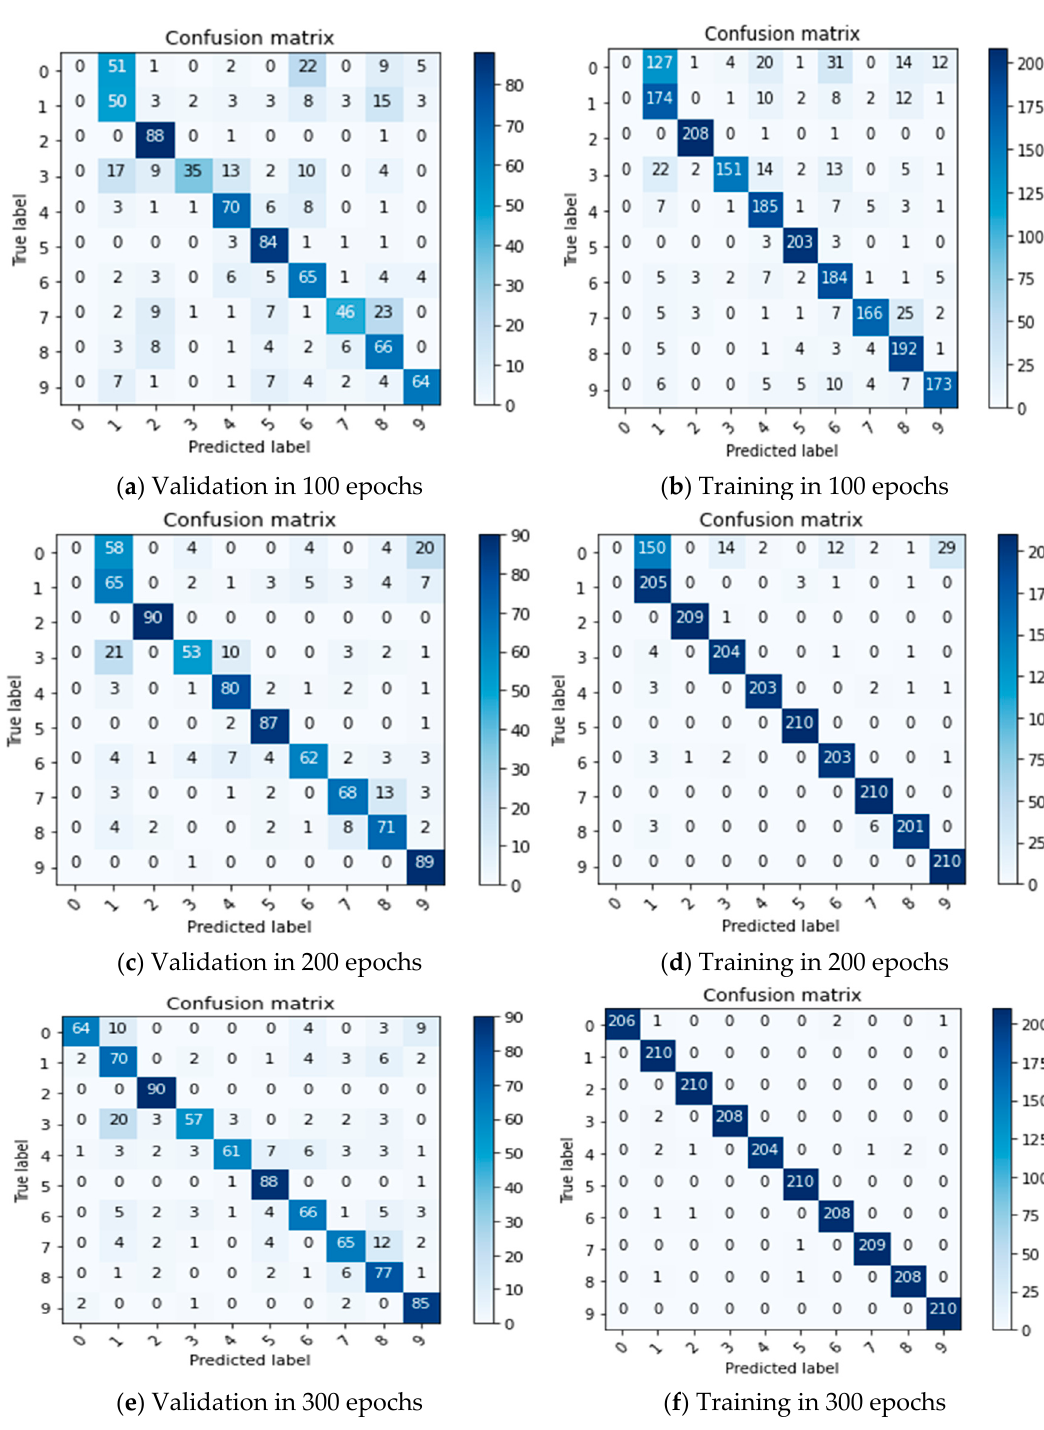
Figure 3. Confusion matrix of validation and training in different epochs.